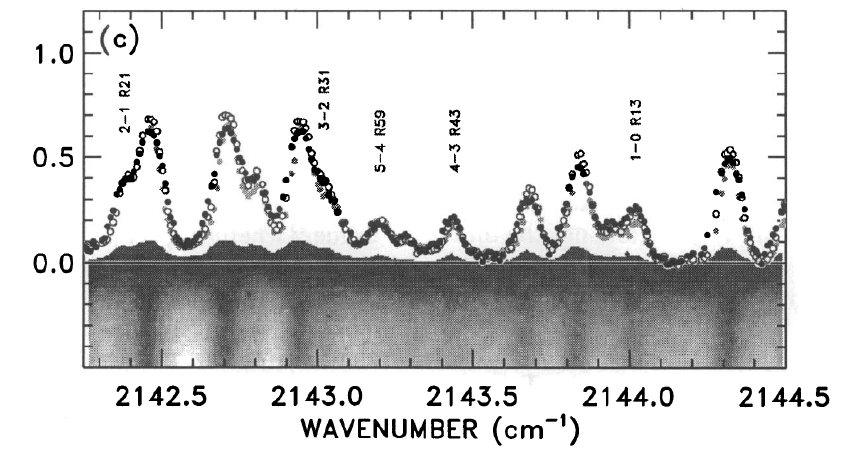
Figure 7: The limb extensions in arcseconds of several CO lines near 4666 nm are shown in this plot. Image reproduced with permission from Ayres and Rabin (1996), copyright by